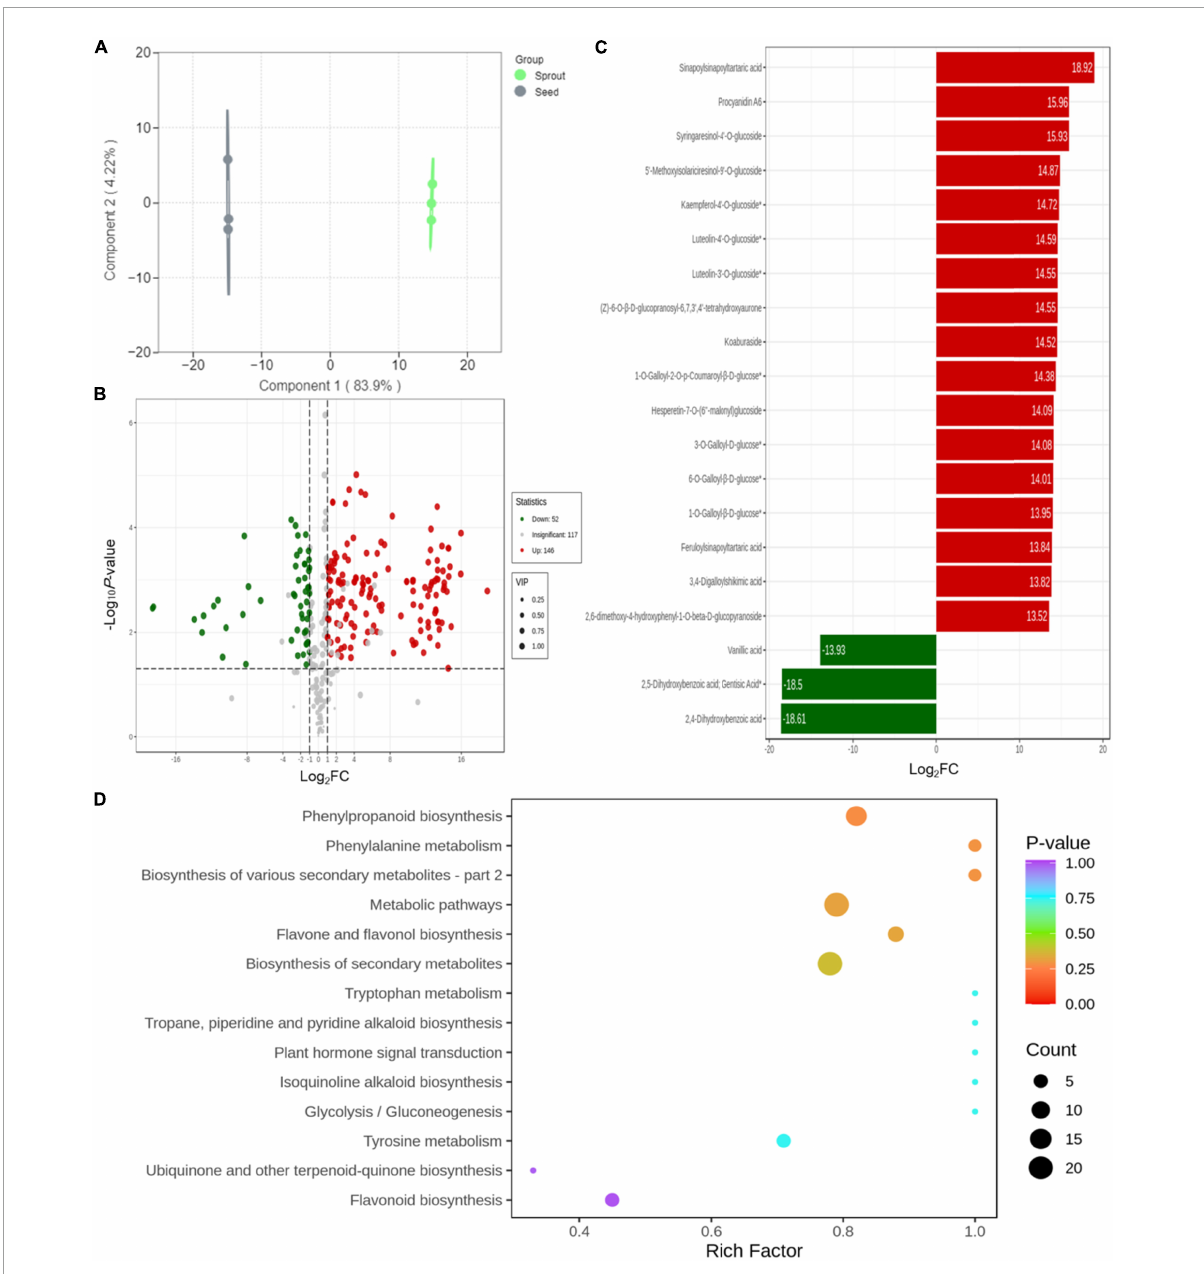
FIGURE4 (A) Orthogonal partial least squares-discrimination analysis result for discriminating of white radish seed and sprout; (B) volcano plots of the up- and down-accumulated metabolites for comparison groups of seed and sprout; (C) bar chart of the top 20 differentially abundant phenolic compounds with the largest fold change (FC) value; (D) KEGG enrichment of differential metabolites in the comparison of seed and sprout.